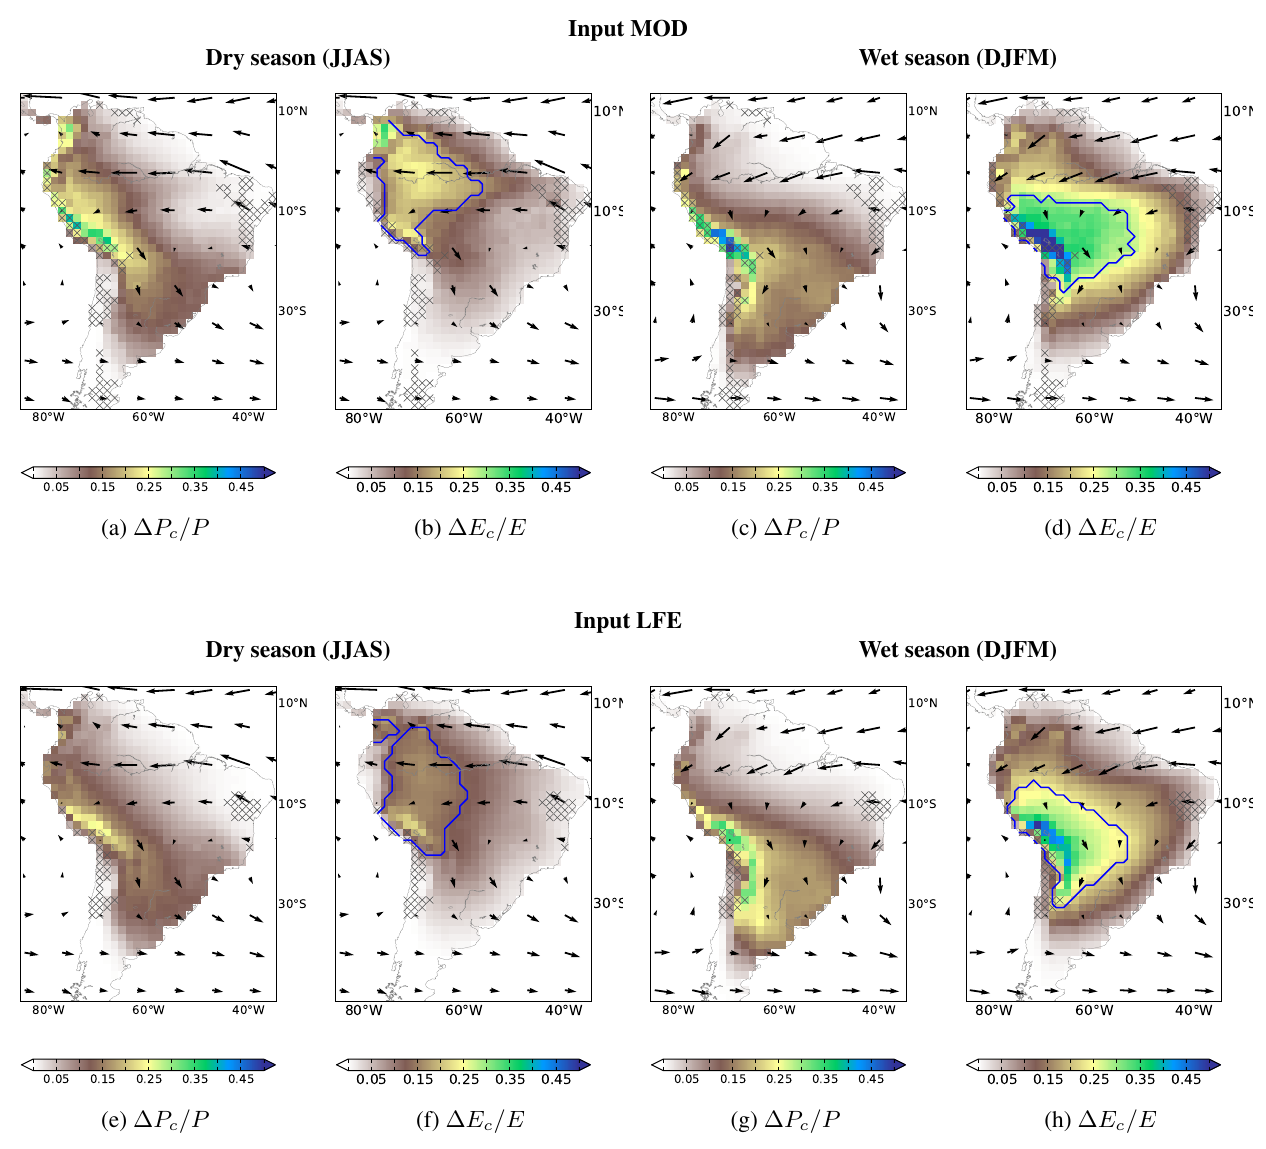
Figure 5. Fraction of total precipitation originating from CMR ( (cid:49)P c /P ) (a, c, e, g) and fraction of total evapotranspiration that lies within CMR pathways ( (cid:49)E c /E ) (b, d, f, h) . While high values of (cid:49)P c /P indicate regions that are dependent on CMR for local rainfall, high values of (cid:49)E c /E indicate regions that contribute to CMR. The blue boundaries define the regions that have (cid:49)E c /E > 80 percentile (calculated for all continental values in each seasonal moisture recycling network) and that are called intermediary regions. Results are obtained using the input MOD (upper row) and input LFE (lower row) (see Table 1) and are given for the dry season (left) and the wet season (right).